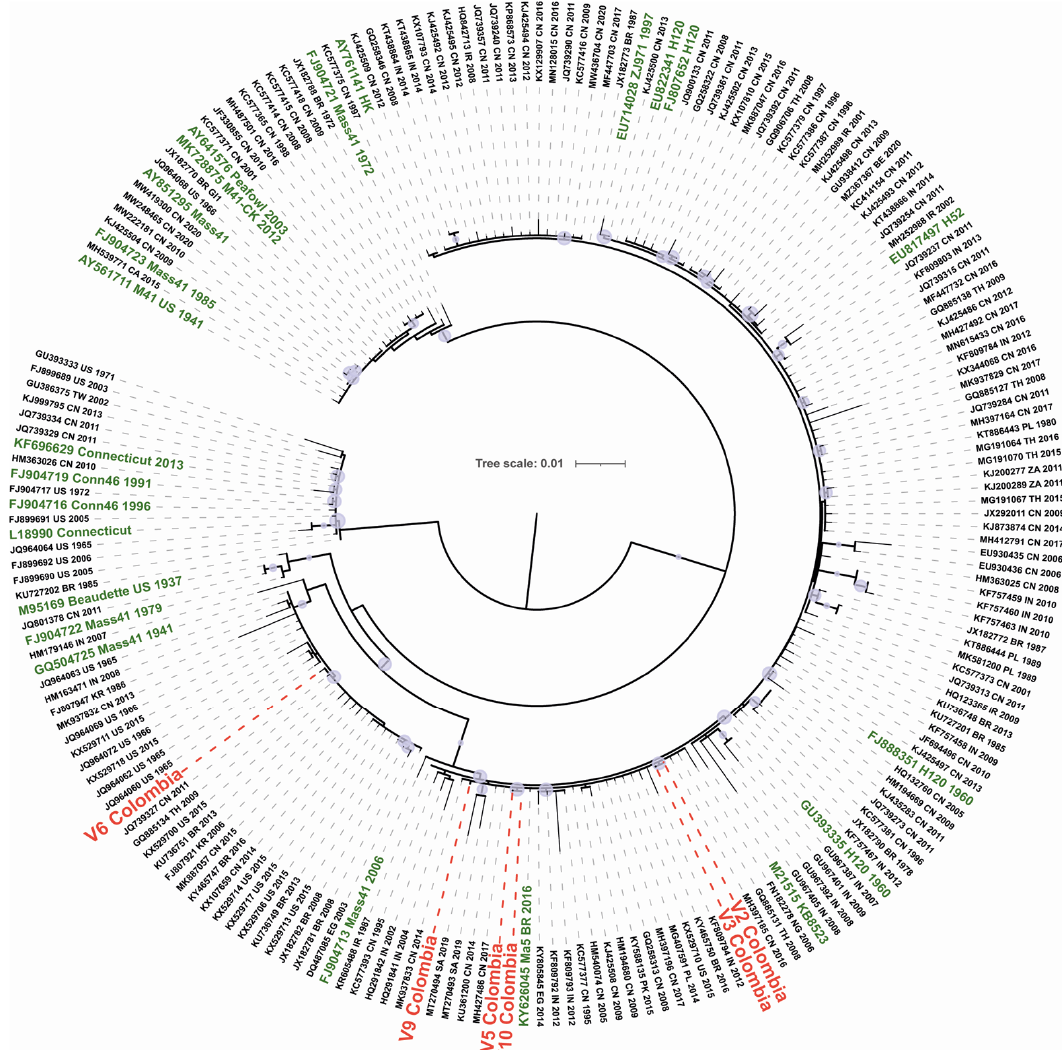
Figure 3. Maximum-likelihood phylogenetic tree of Infectious Bronchitis Virus (IBV) S1 gene se- quences from the GI-1 clade ( n = 203). Red labels correspond to IBV Colombian sequences and green labels to vaccine strains. Circles at the nodes denote SH-aLRT branch support values larger than 80%. The tree was midpoint rooted and the length of the branches are drawn to scale with the bar at the middle indicating nucleotide substitution per site.